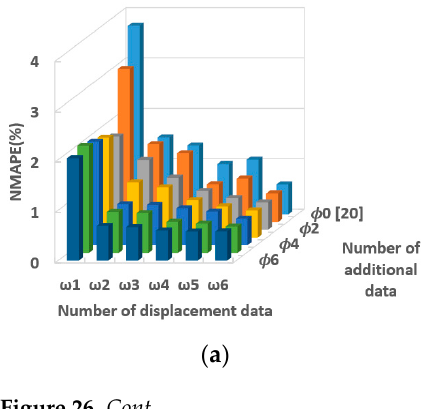
Figure 25. Example of estimated deformed shape according to the sensor number and combination (RDS4): ( a ) number of data ( ω = 1 ), ( b ) number of data ( ω = 1,∅ = 3 ), ( c ) number of data ( ω = 1,ε = 4 ), ( d ) number of data ( ω = 1,∅ = 3,ε = 3 ).